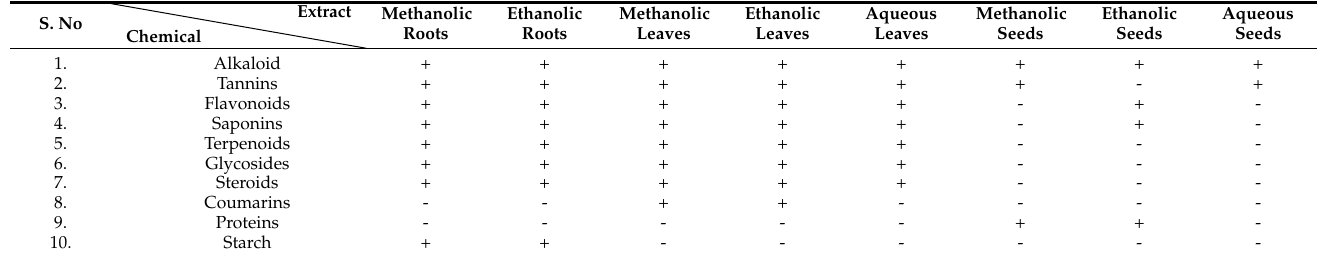
Table 4. Phytochemicals present in different plant part extracts of M. oleifera .